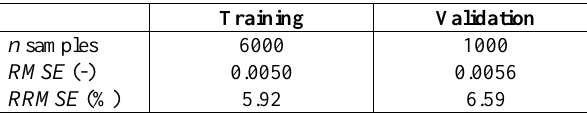
Table 3 . Emulator training and validation synthetic sample sizes and performance statistics.